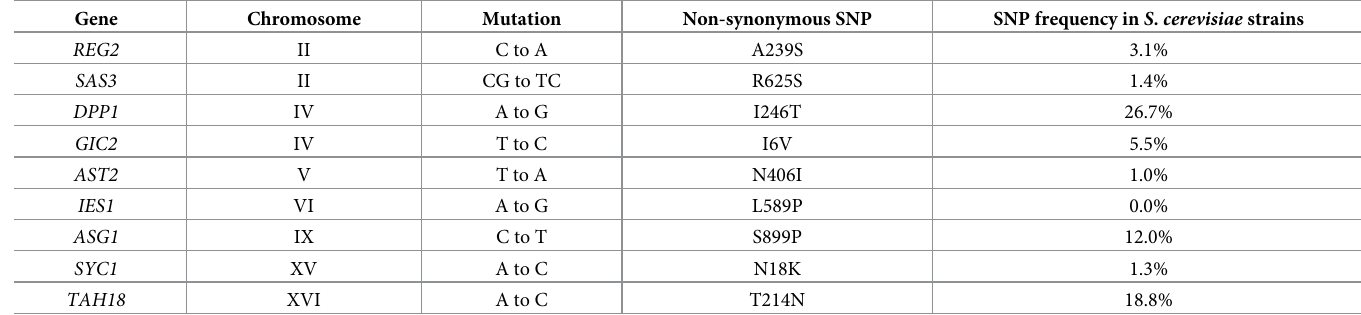
Table 1. List of the nine non-synonymous SNPs present in GVM1, segregant of the WG transformant GVM0, compared to the parent strain MD4. SNP frequency was determined as percentage of 1011 whole-genome sequenced strains that contained the non-synonymous SNP. Gene